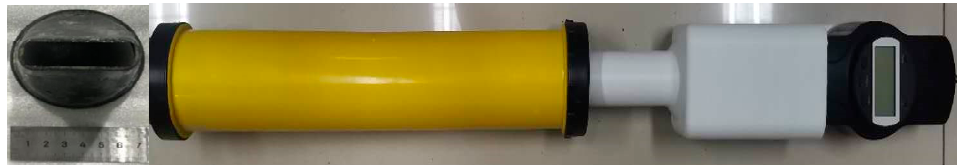
Figure 3. The elastic connecting rod of extrudability tester deformation changes electric